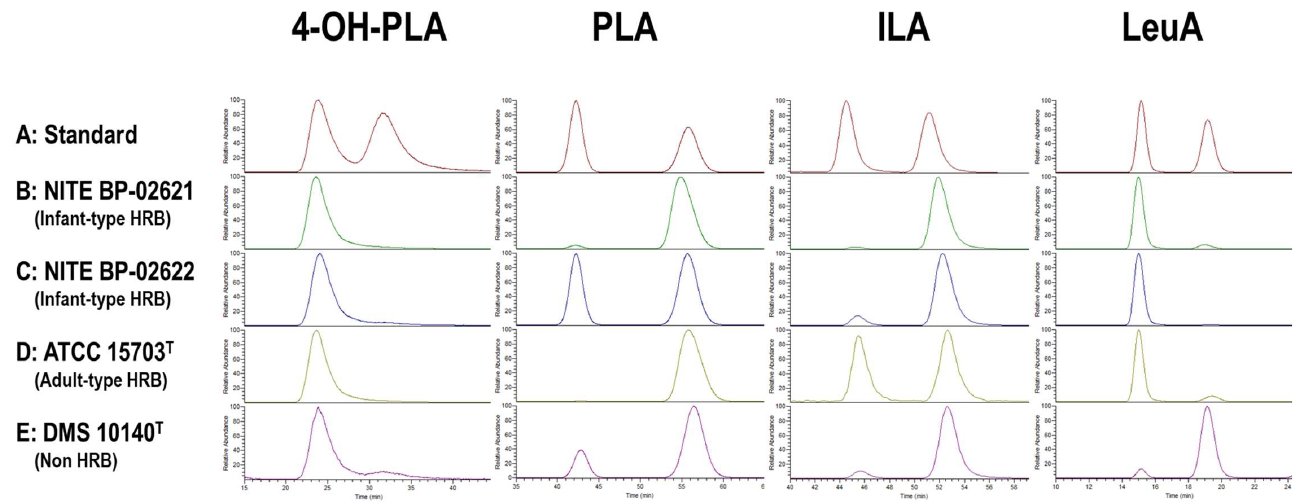
Figure 1. Chiral chromatography of aryl-lactic acids (aryl-LAs) and leucic acid (LeuA). The earlier retention time peak is labeled as “1st.” ( A ) Authentic standards for DL-4-OH-PLA, PLA, and ILA. ( B – E ) CS samples of B. longum subsp. longum (NITE BP-02621), B. breve (NITE BP-02622), B. adolescentis (ATCC15703 T ), and B. animalis subsp. lactis (DSM10140 T ).